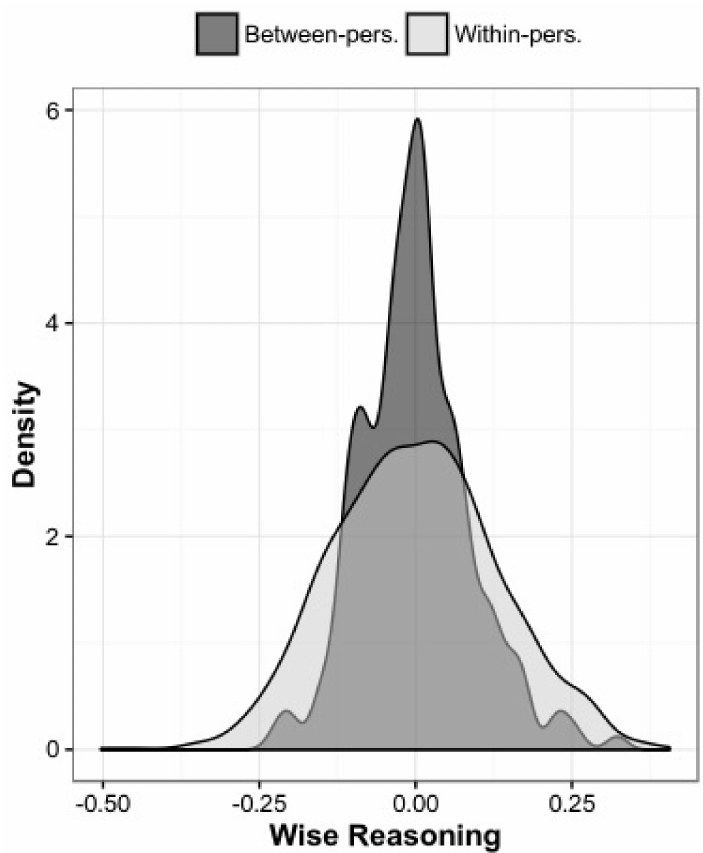
Figure 1. Density distribution of wise reasoning (intellectual humility, consideration of uncertainty/change, perspective-taking) in everyday life, based on reflections about the most challenging issues people encountered across nine days. Within-pers. = Variability of person’s scores from their mean. Between-pers. = Between-person variability in person’s average responses across nine days. Adopted from